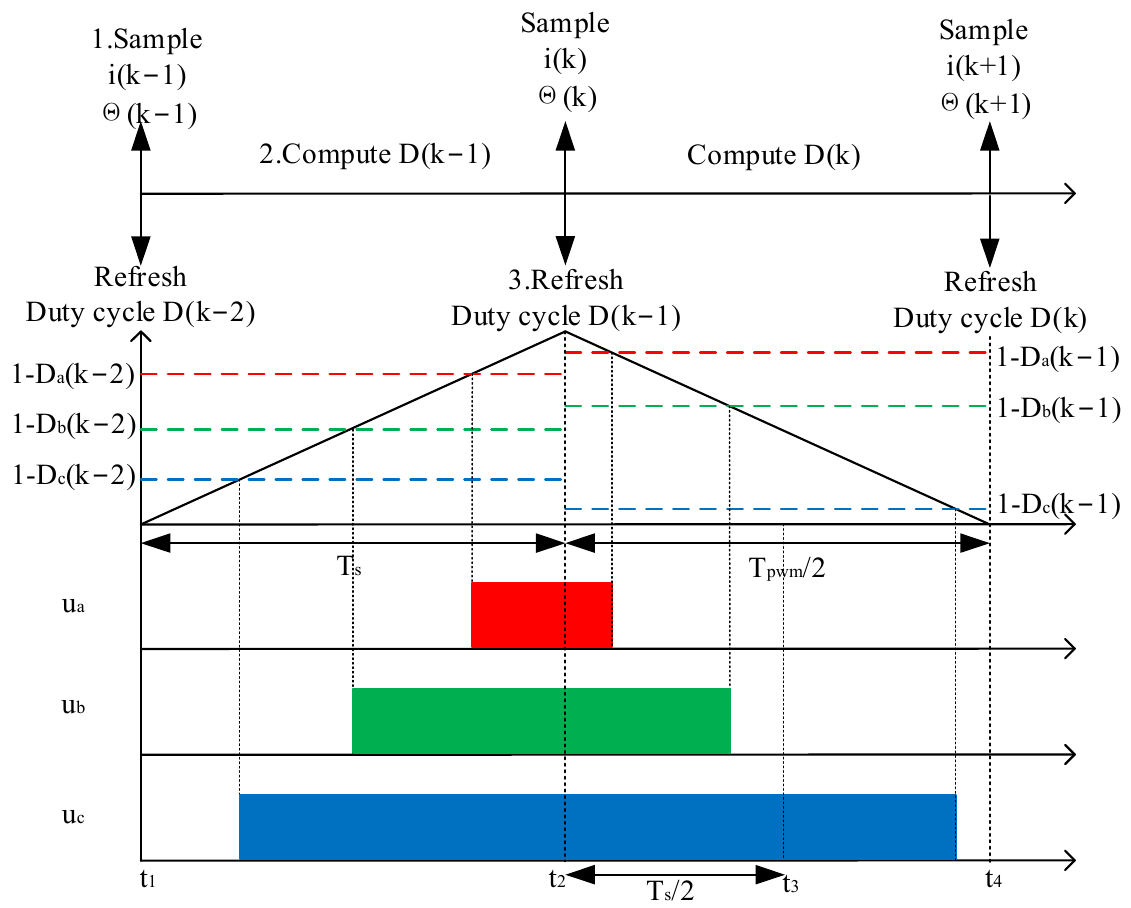
Figure 3. Chronological chart of sampling and outputting of DSDU. To illustrate the deviation between the given value and the output value, Figure 4 presents a two-pole machine model with the rotor rotating (aligned with direct-axis). Supposing the rotor speed ω e is steady, the rotor position of the north pole at the three sampling instants t 1 , t 2 and t 4 are d ( t 1 ) , d ( t 2 ) , d ( t 4 ) . After sampling at t 1 and computing during t 1 − t 2 , the duty cycle information is updated to the register at t 2 . During the outputting time ( t 2 − t 4 ), the rotor still rotates at the speed of ω e . The actual output voltage vector during t 2 − t 4 can be calculated by (13),